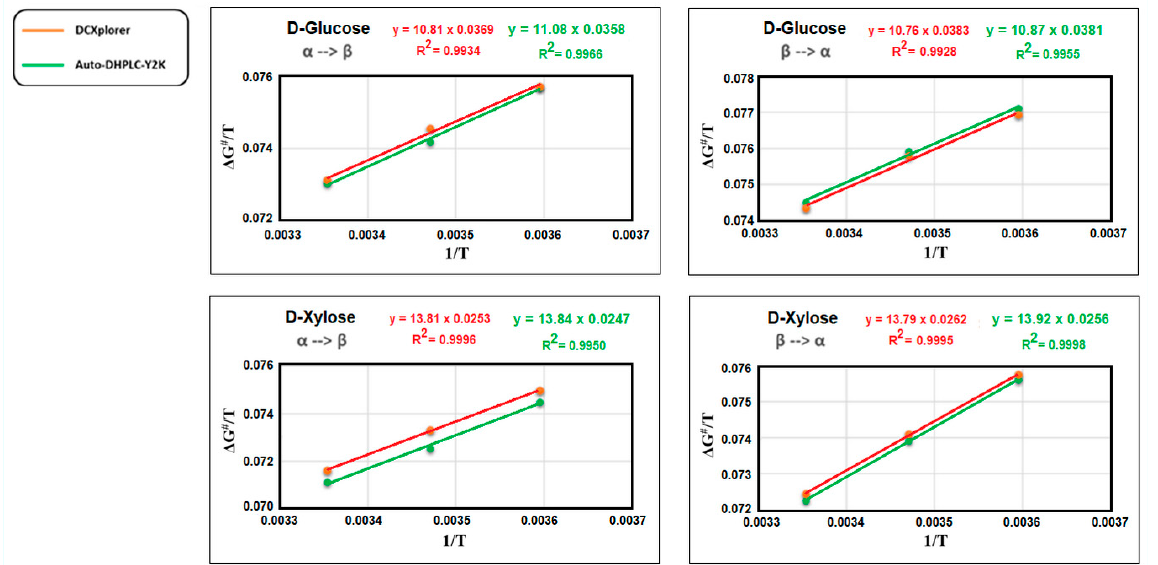
Figure 5. Comparison of the van’t Hoff plots obtained by using ∆ G # values computed from the related kv app data evaluated through the simulations of computational programs Auto-DHPLC-Y2K, green line, and DCXplorer, red line.